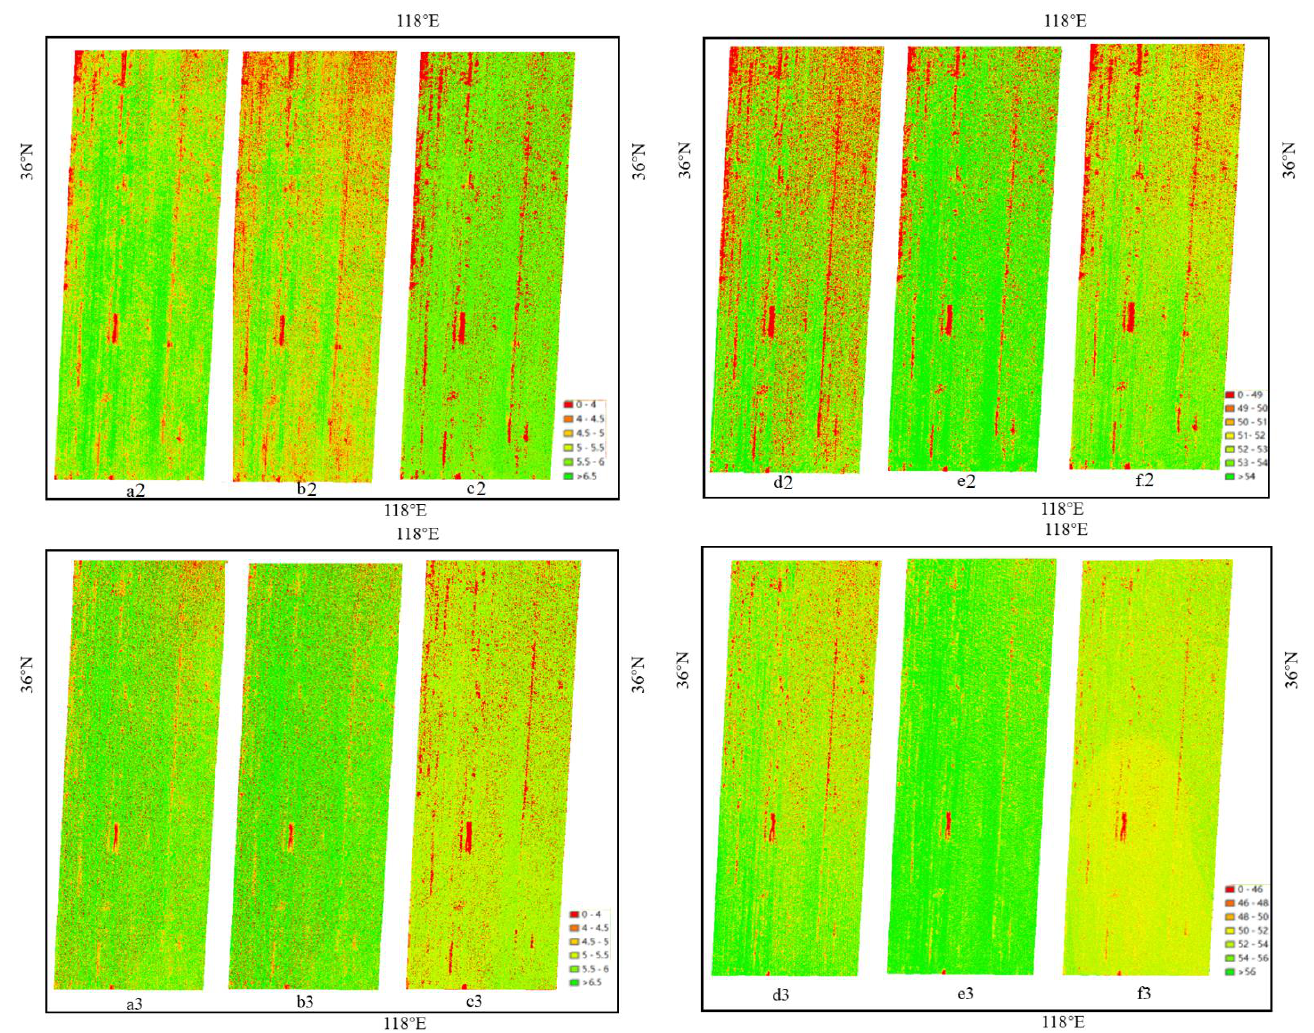
Figure 6. The inversion diagram of each model in the trumpet period, tasseling period and blistering period in 2020. ( a1 – a3 ) MLR model; ( b1 – b3 ) PLSR model; ( c1 – c3 ) RF model; ( d1 – d3 ) MLR model; ( e1 – e3 ) PLSR model; ( f1 – f3 ) RF model. ( a – c ) is the inversion model of LAI; ( d – f ) is the inversion model of SPAD. ( a1 )~( f1 ) are the inversion diagrams in the trumpet period. ( a2 )~( f2 ) are the inversion diagrams in the tasseling period. ( a3 )~( f3 ) are the inversion diagrams in the blistering period. Table 7. The mean value of the root-mean-square error for the model differences in each period. Model Trumpet